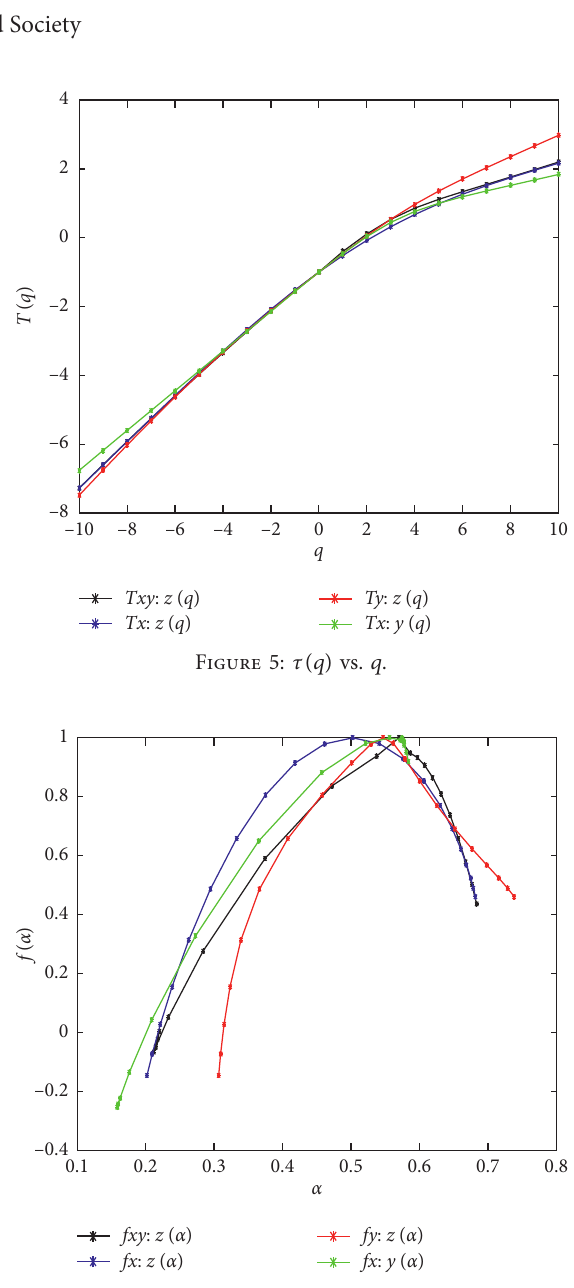
Figure 6: The strength of the multifractality.